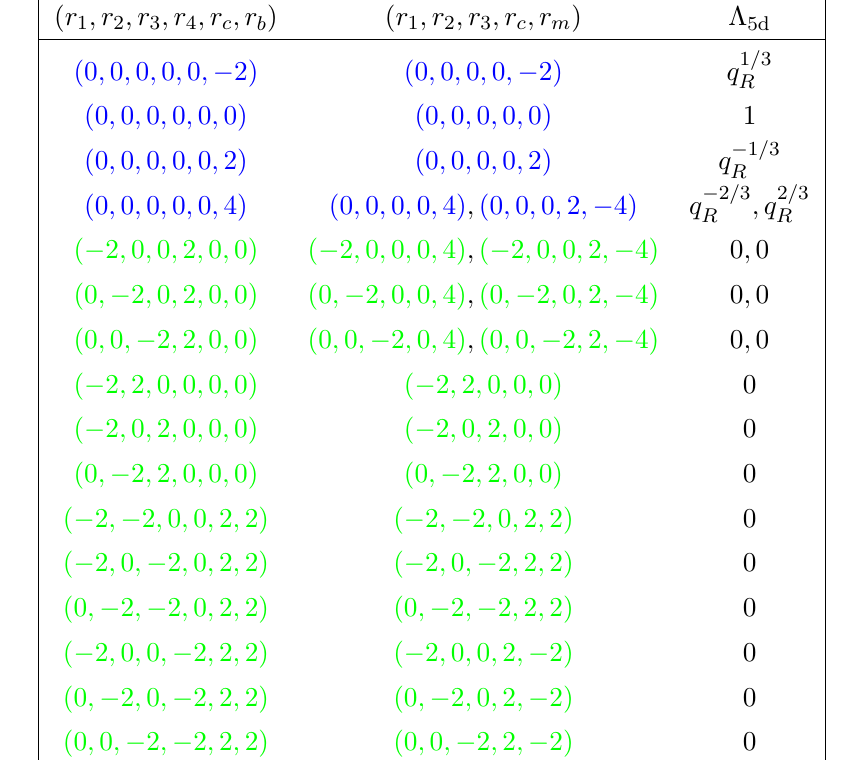
Table 4. Reduction of 6d r (cid:12)elds to 5d r (cid:12)elds and the corresponding (cid:3) Unity and vanishing r (cid:12)elds are colored in blue and green